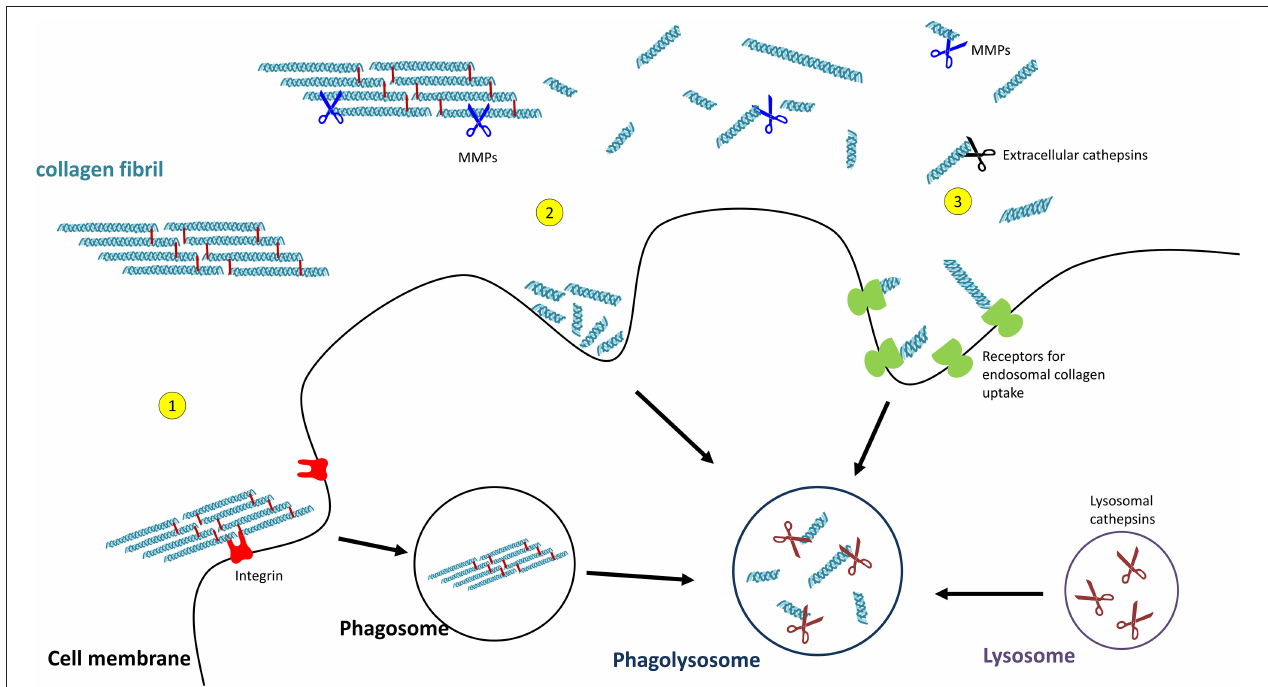
FIGURE 4 | Pathways of collagen degradation. Both extracellular degradation by MMPs and extracellular cathepsins on the one hand and intracellular degradations by (1) collagen phagocytosis, (2) macropinocytosis, or (3) receptor-mediated endocytosis occurs.